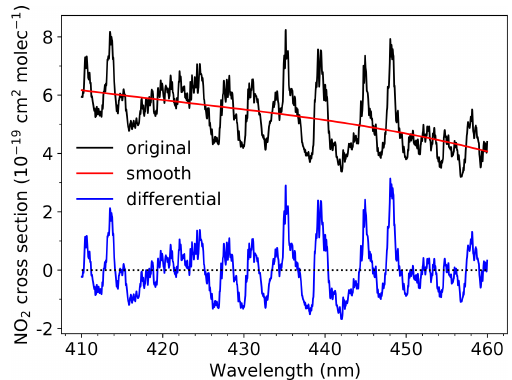
Figure 6. Illustration of the principle of DISMAS using the NO 2 cross section as an example. The NO 2 cross section is separated into two parts: a smooth part, using a fit of a third-order polyno- mial, and a differential part. The radiative transfer calculations are performed for the smooth part at a few selected wavelengths where the differential cross section is